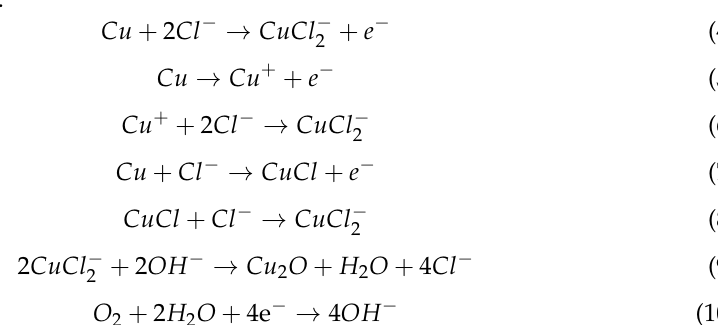
Figure 10a. The accompanying cathodic reaction is the oxygen reduction reaction (ORR) through Equation